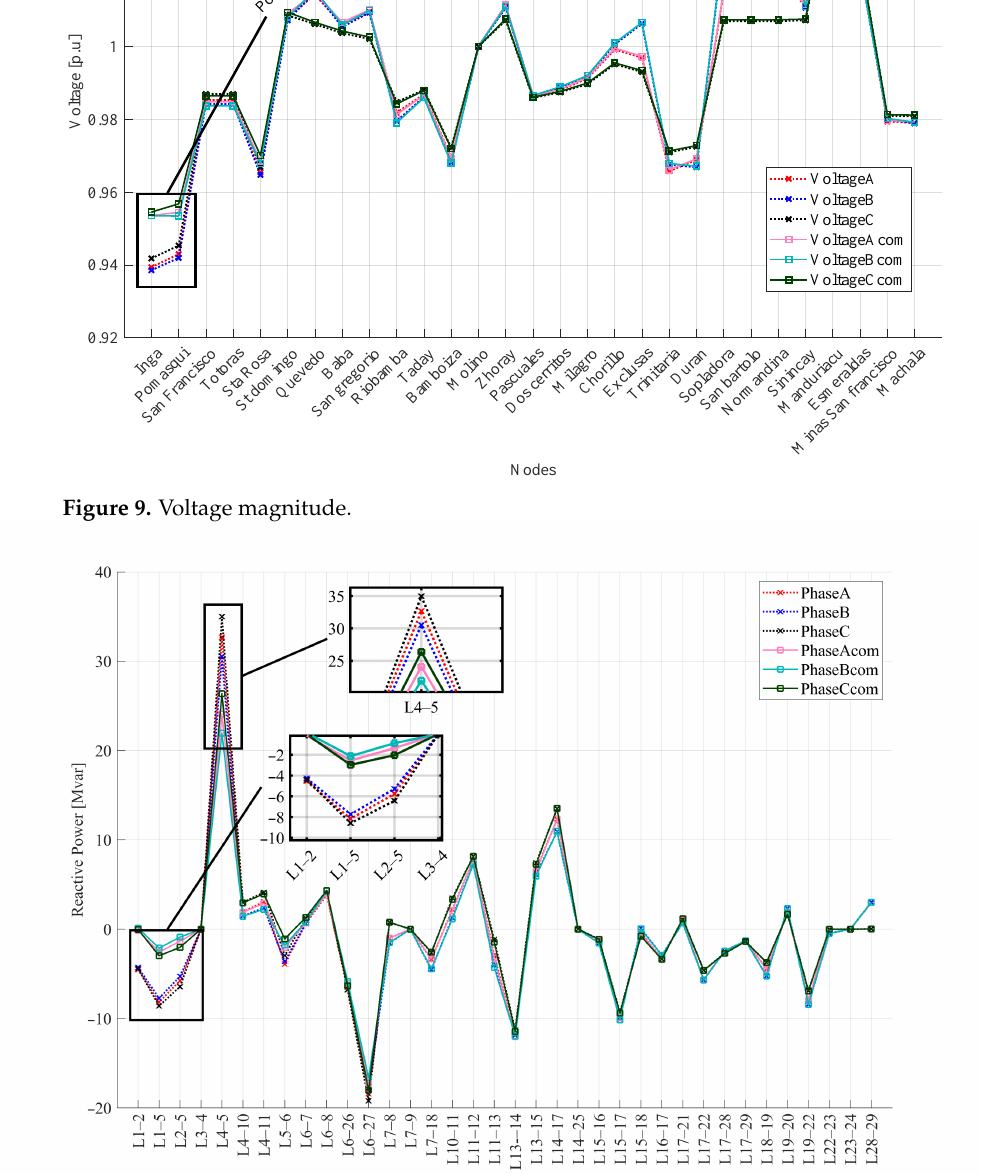
Figure 10. Reactive power of transmission